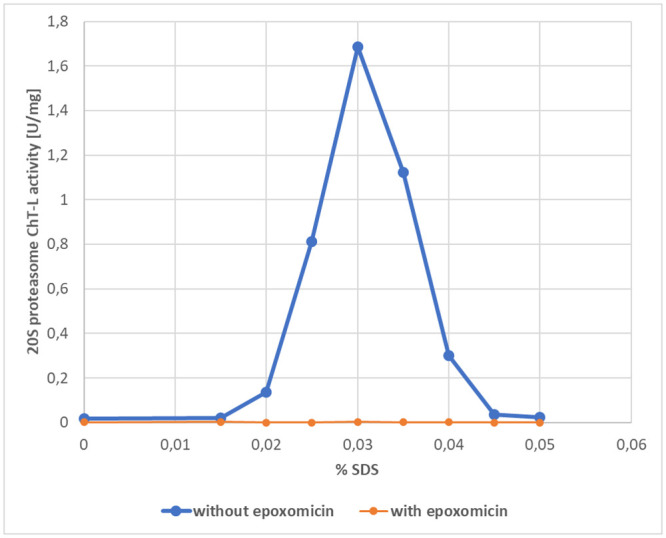
Sodium dodecyl sulfate (SDS) activation profile for Suc-Leu-Leu-Val-Tyr-AMC hydrolyzing activity in the absence or presence of the proteasome inhibitor epoxomicin in plasma of patient with brain tumor.